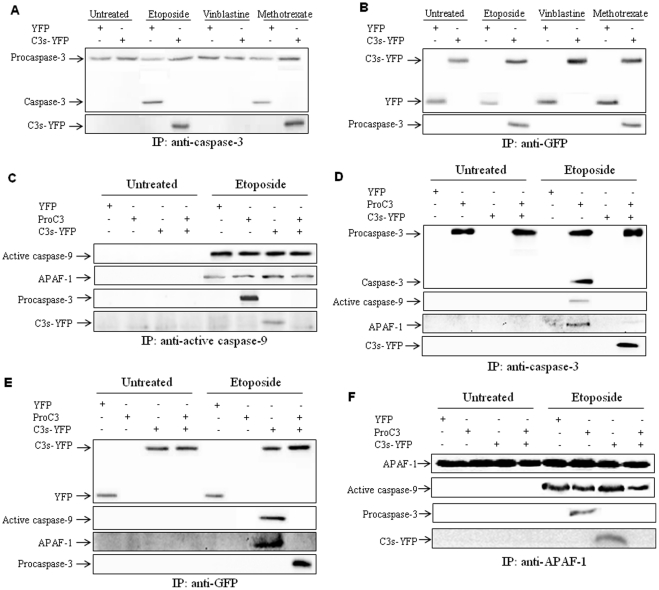
Caspase-3s interacts with procaspase-3 and inhibits the apoptosome assembly.
A–B. This experiment was carried out in HBL100 cells stably transfected with caspase-3s-YFP or YFP alone and treated with etoposide, vinblastine or methotrexate for 48 hours. A. In YFP transfected cells, immunoprecipitations were performed with anti-caspase-3 antibody and western blot with anti-GFP (that recognizes YFP in YFP transfected cells and the caspase-3s YFP tag) and anti-caspase-3 antibodies. The results revealed no interaction between caspase-3 and YFP with or without treatment. In HBL100 transfected with caspase-3s-YFP, an interaction between procaspase-3 and caspase-3s after etoposide or methotrexate treatments was observed. B. In YFP transfected cells, immunoprecipitations were performed with anti-GFP antibody and western blot with anti-caspase-3 and anti-GFP antibodies. The results revealed no interaction between YFP and procaspase-3 whatever the conditions. In caspase-3s-YFP transfected HBL100, an interaction between caspase-3s and procaspase-3 was observed after etoposide or methotrexate treatment. C–F. MCF-7 cells were transfected with empty-vector (YFP), procaspase-3 (ProC3) or caspase-3s-YFP (C3s-YFP) or both caspase-3s-YFP and procaspase-3. The cells were treated or not with etoposide. C. Immunoprecipitations were performed with anti-active caspase-9 antibody and western blot with anti-active caspase-9, anti-Apaf-1, anti-caspase3 and anti-GFP (that recognizes caspase-3s tag) antibodies. The results showed that procaspase-3 and caspase-3s interacted, in treated cells, with active caspase-9 and anti-Apaf-1 only when they are alone. As soon as caspase-3s and procaspase-3 are present at the same time, the interaction with active caspase-9 and anti-Apaf-1 was abolished. D. Immunoprecipitations were performed with anti-caspase-3 antibody and western blot with anti-caspase-3, anti-Apaf-1, and anti-active caspase-9 antibodies. The results showed that procaspase-3 interacted with active caspase-9 and anti-Apaf-1 in treated cells only in absence of caspase-3s. E. Immunoprecipitations were performed with anti-GFP antibody and western blot with anti-GFP, anti-Apaf-1 and anti-active caspase-9 antibodies. The results showed that YFP did not interact with active caspase-9 and anti-Apaf-1 whereas caspase-3s interacted with active caspase-9 and anti-Apaf-1 in treated cells only in absence of procaspase-3. F. Immunoprecipitations were performed with anti-Apaf-1 antibody and western blot with anti-Apaf-1, anti-active caspase-9, anti-caspase-3 and anti-GFP antibodies. The results showed that procaspase-3 and caspase-3s interacted, in treated cells, with active Apaf-1 and caspase-9 only when they are alone. As soon as caspase-3s and procaspase-3 are present at the same time, the interaction with Apaf-1 and active caspase-9 was abrogated.